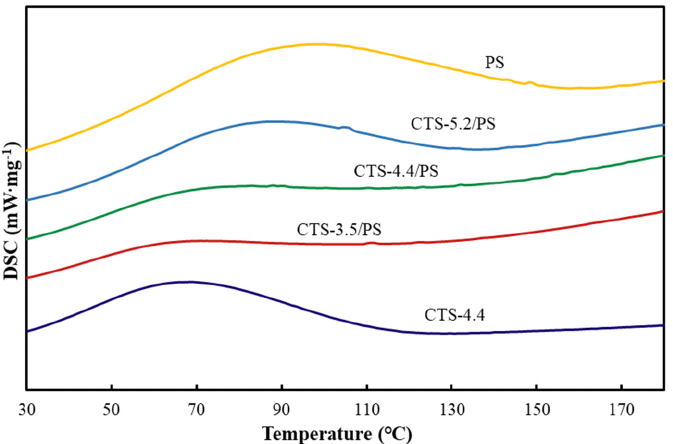
Figure 8. DSC diagrams of raw materials and CTS/PS foams. Table 9. The glass transition temperature and enthalpy of samples.